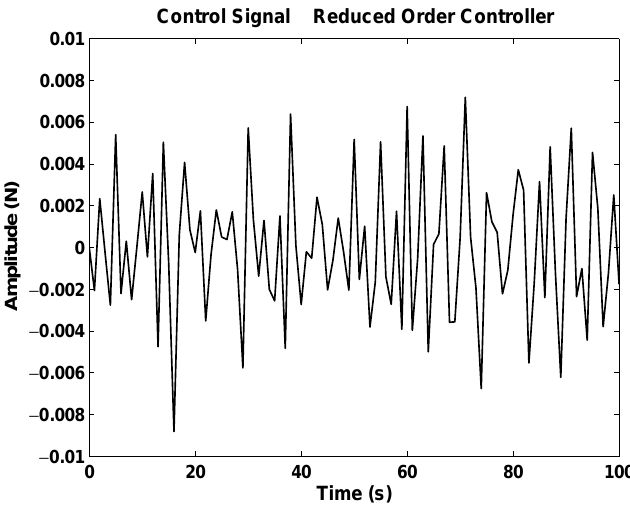
Fig. 10. Control signal – reduced order controller.